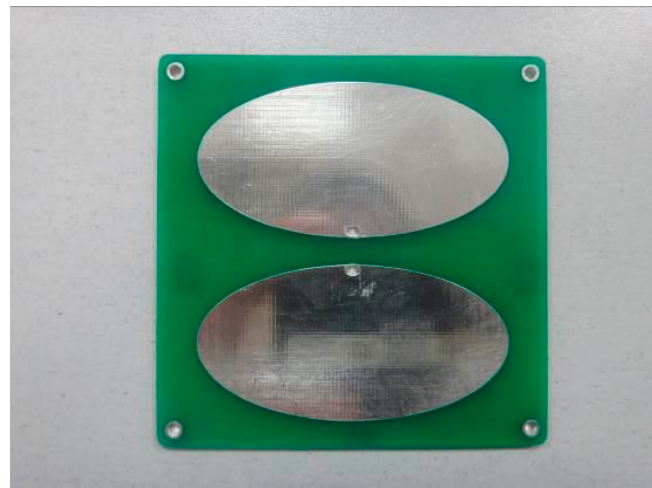
Figure 7. Elliptical dipole printed antenna panel.